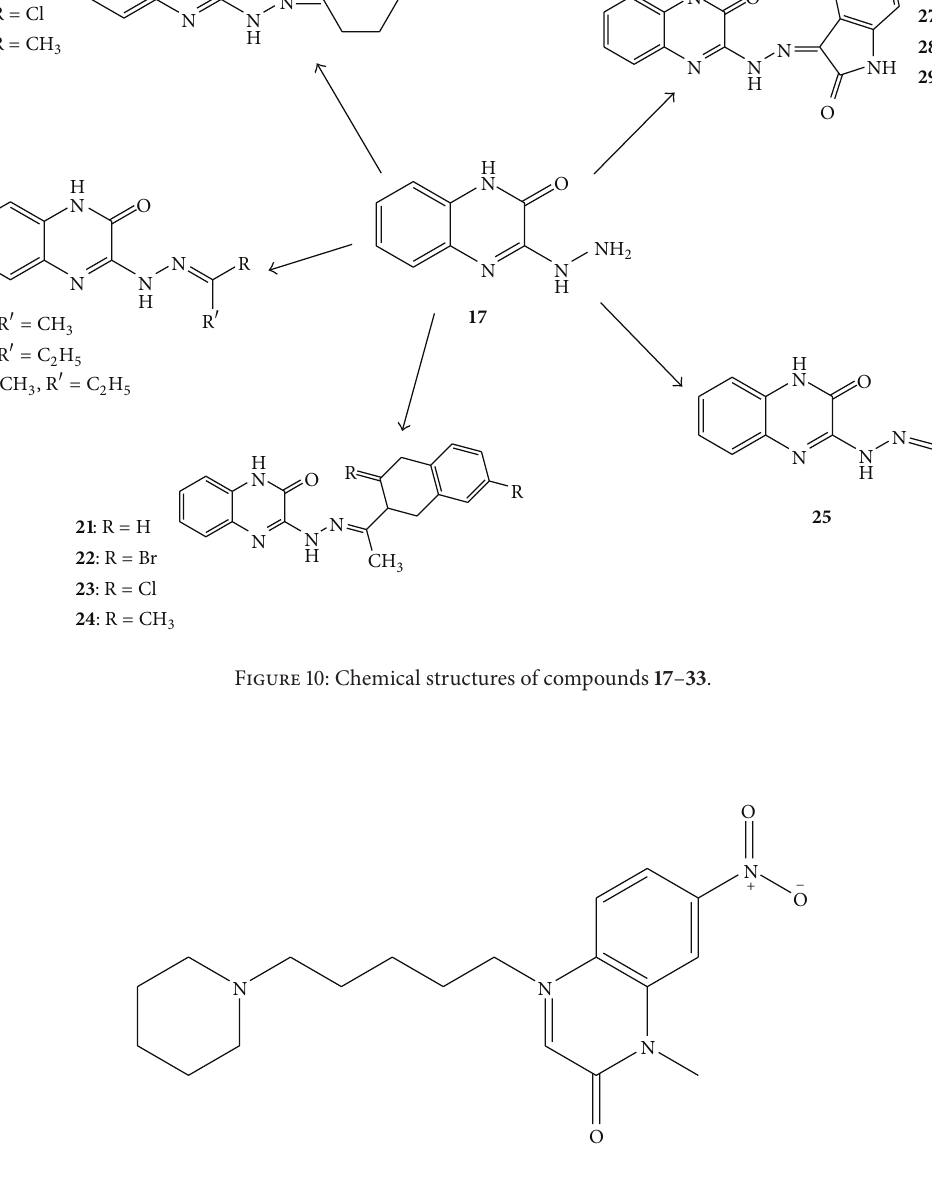
Figure 11: Chemical structures of compound 34